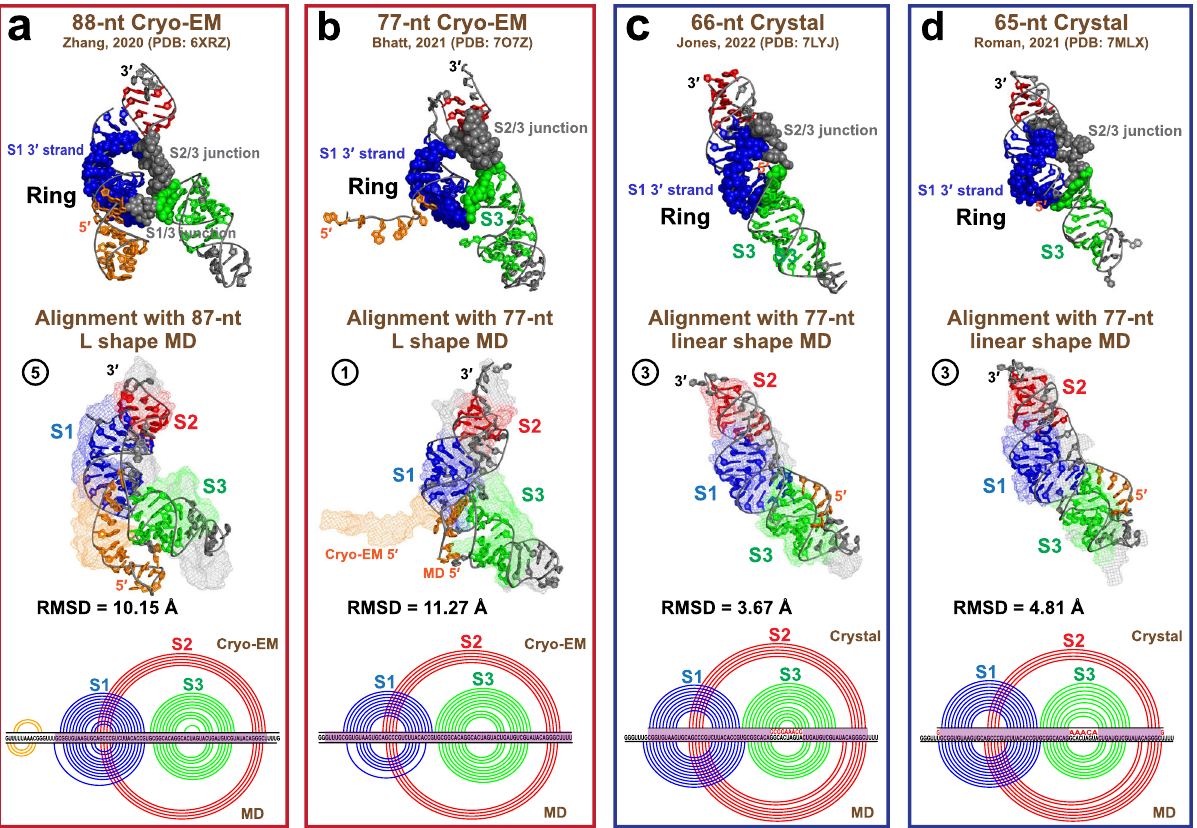
Fig. 4 MD 3_6 structures compared to four experimental structures. a , Top The 88-nt Cryo-EM structure (PDB: 6XRZ) 19 in the threaded ring conformation is (Middle) aligned with our 87-nt L shape MD structure (Cryo-EM structure in mesh mode, MD in cartoon), with (Bottom) 2D structural comparisons (Cryo-EM arc plot at top, MD at bottom). The 3D structure alignment is performed by PyMol 77 for the center 67 residues (highlighted in purple in the 2D plot), and the RMSD is computed. b Comparison between the 77-nt FSE segment extracted from the mRNA-ribosome Cryo-EM structure (PDB: 7O7Z) 20 and our 77-nt L shape MD structure. c , d Comparisons between the crystal structures (PDB: 7LYJ 45 and 7MLX 22 ) and our 77-nt linear shape MD structure. The mutated Stem 3 loop residues in the crystal structures are colored red in the 2D structural comparisons at